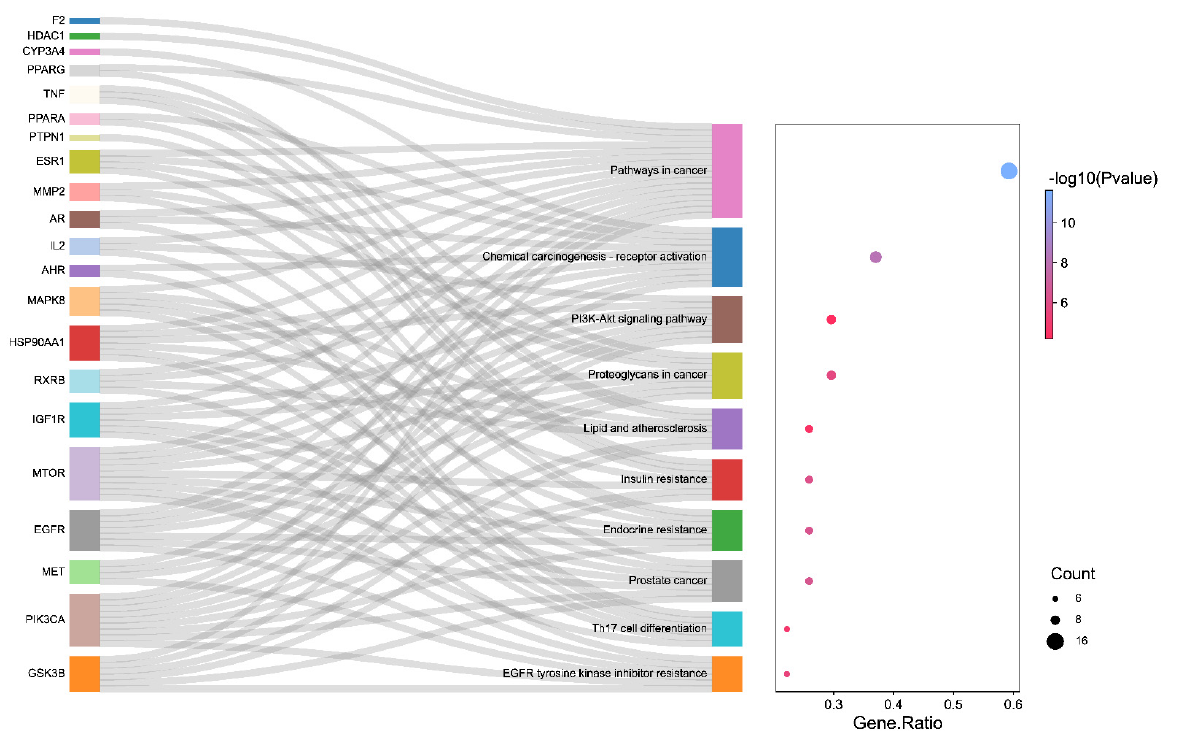
Figure 6. The Sankey diagram of major targets involved in the KEGG signaling pathways (top 10 were listed).